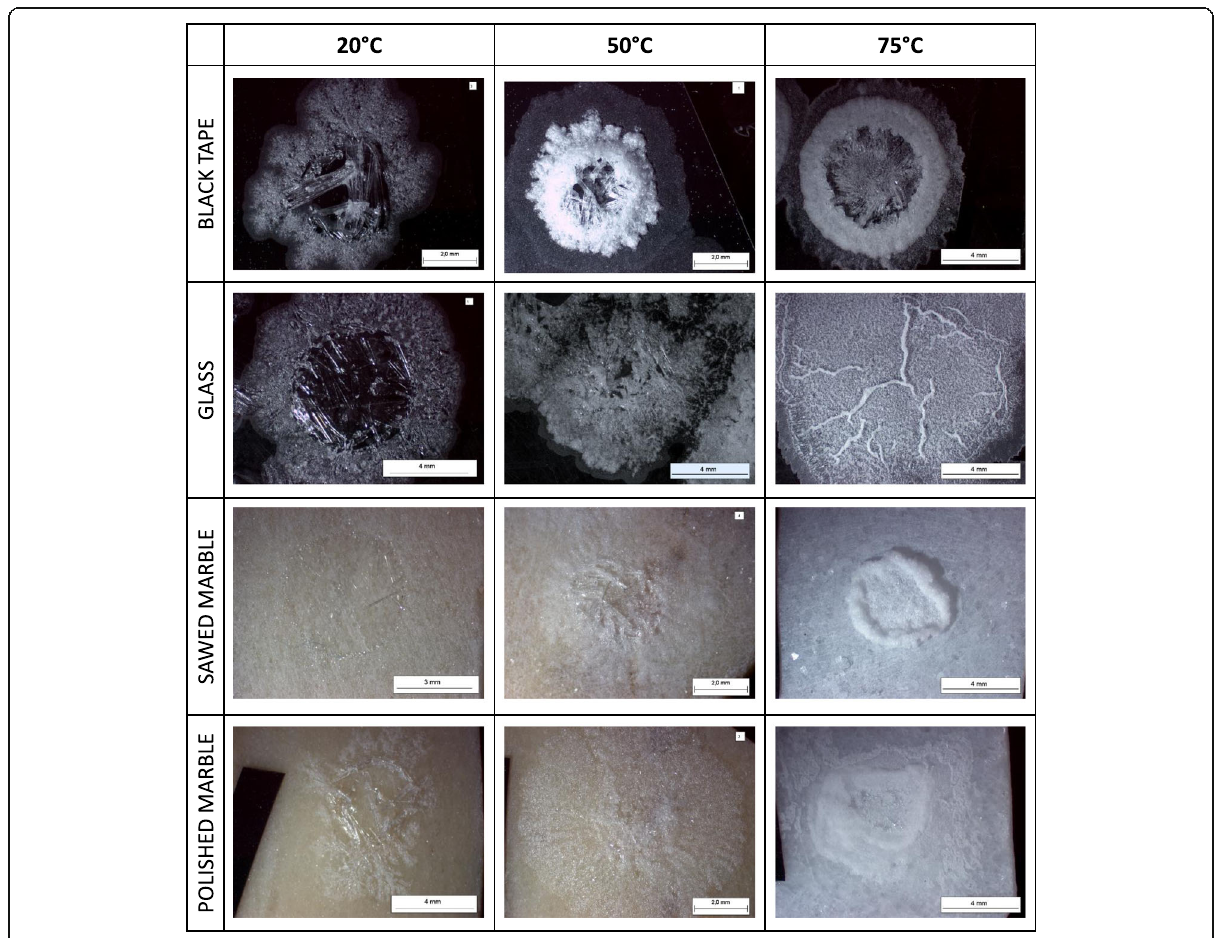
Fig. 3 Evaporated droplets. Pictures of a representative evaporated droplet for each substrate and temperature